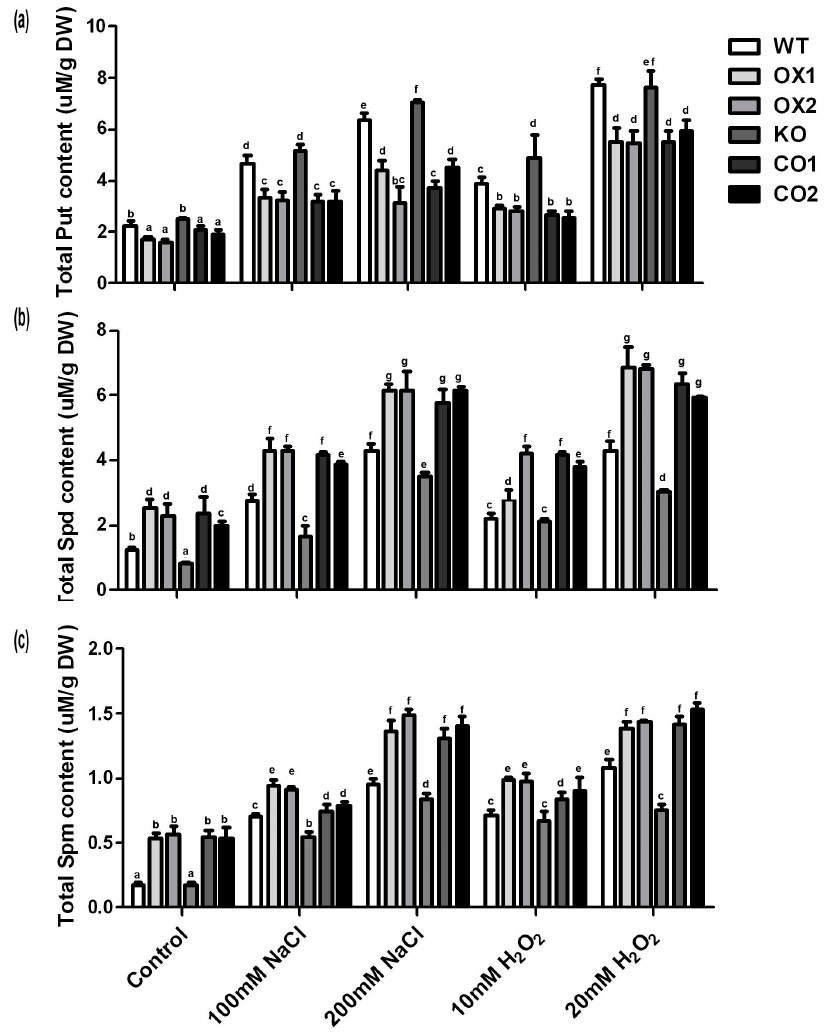
Figure 7. Effects of salt and H 2 O 2 stresses on polyamines (PAs). Total putrescine (Put) content ( a ); total spermidine (Spd) content ( b ); total spermine (Spm) content ( c ) in wild type (WT), transgenic BvM14-SAMS2 seedlings in wild type Arabidopsis (OX), atsams3 mutant (KO) and BvM14-SAMS2 in mutant complementation seedlings (CO) leaves. Data are the means of three biological replicates with standard deviation (SD), and each replicate contains five seedlings. Different letters indicate significant difference at p < 0.05.